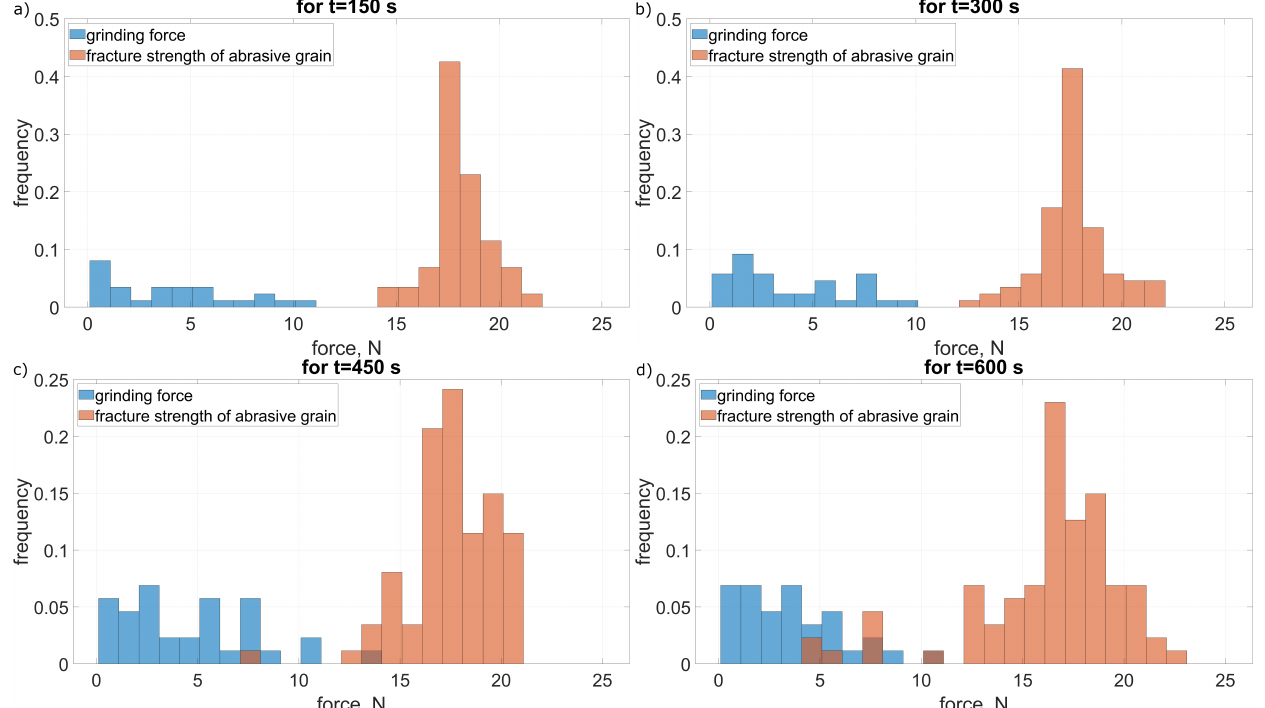
Figure 9. Grinding forces distribution F z (Equation (15)) and fracture strength w z (Equation (16)) of the abrasive grain for low grain fracture (pull-out) intensivity at: ( a ) 150 s, ( b ) 300 s, ( c ) 450 s and ( d ) 600 s of grinding time.